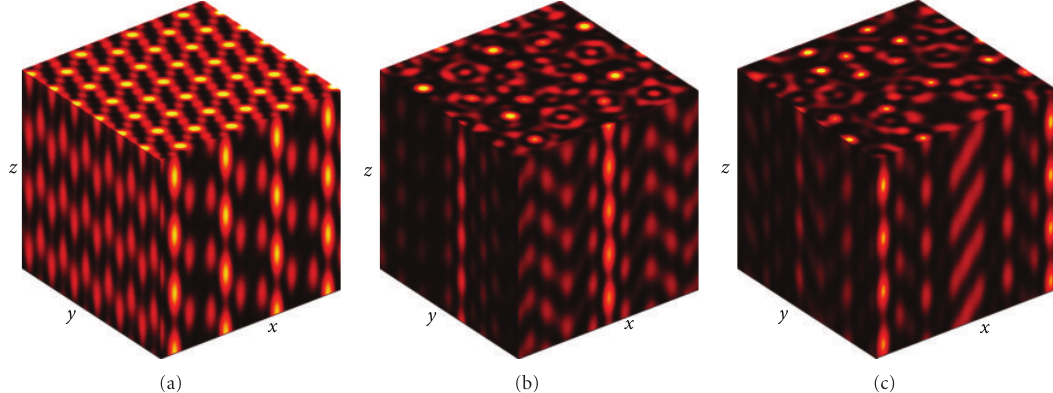
Figure 5: Computer simulations of intensity distributions of complex 3D photonic vortex lattices. Taking the multiples of relatively phase- shifted three beams, where the numbers of interfering beams involved are, respectively, (a) 6 + 1 beams, (b) 9 + 1 beams, and (c) 15 + 1